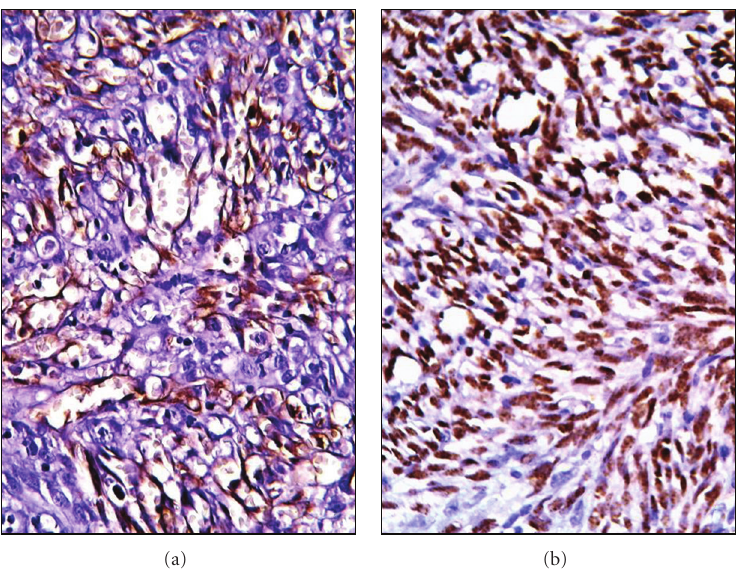
Figure 2: CD31 (a) and HHV-8 (b) immunoreactivity in neoplastic spindle cells ((a)-(b): AEC-DAB, x400).